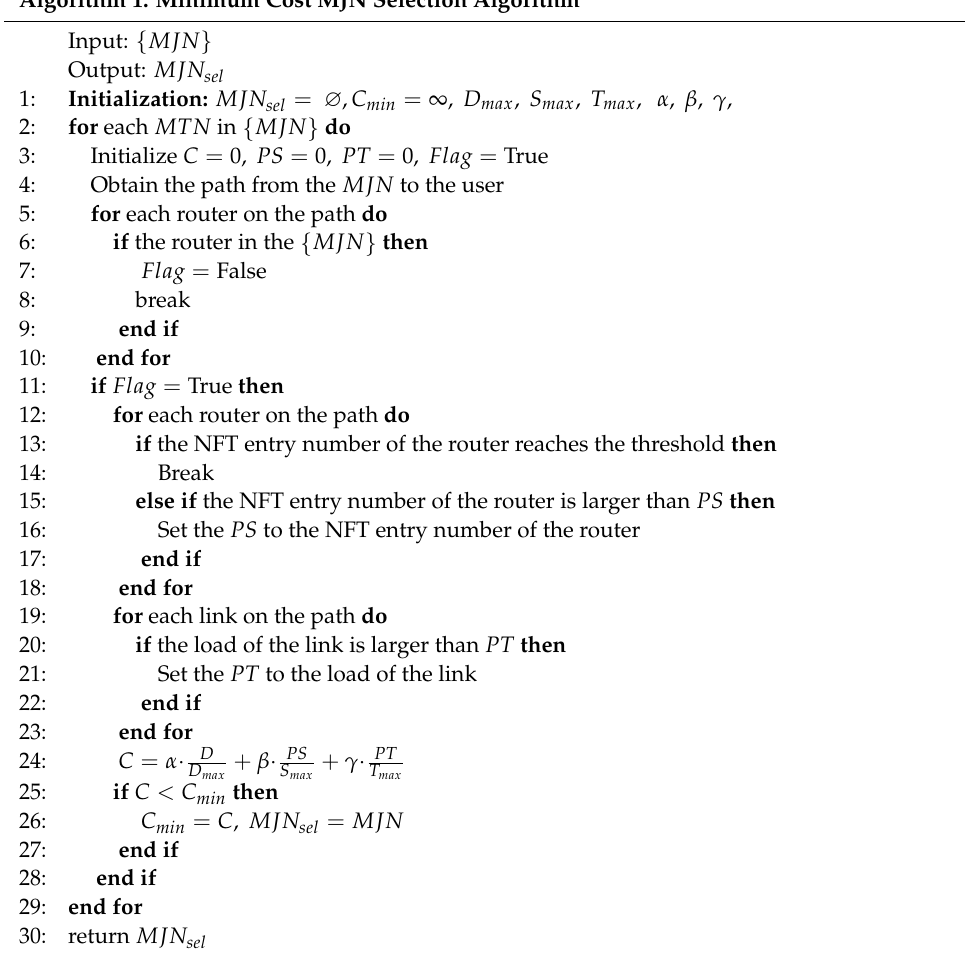
Algorithm 1. Minimum Cost MJN Selection